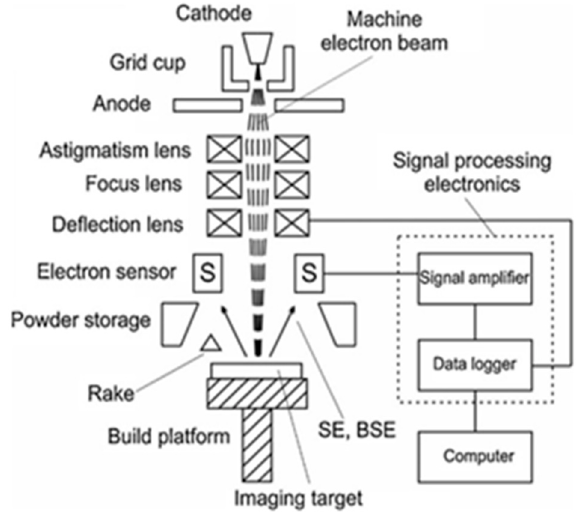
Figure 16. Electronic microscope schematic [63].